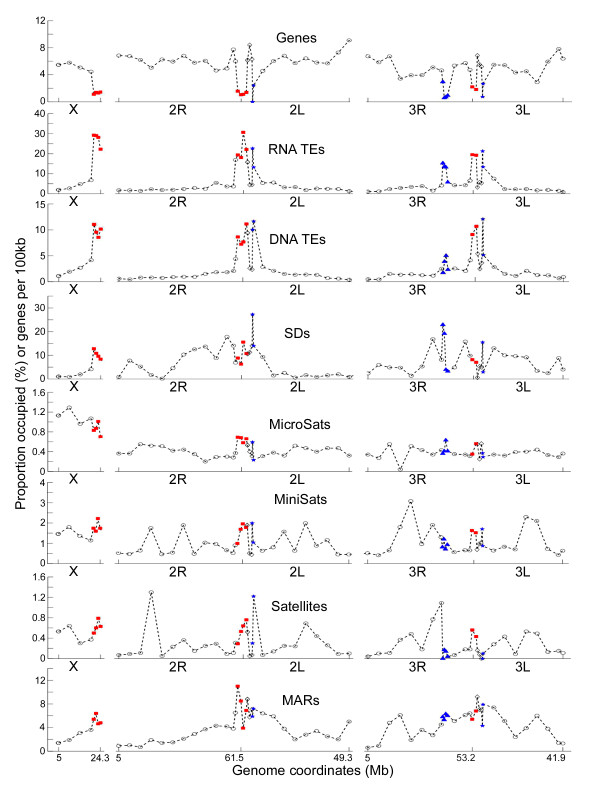
Genome landscapes of the An. gambiae heterochromatin and euchromatin. Median values of coverage of molecular features are displayed as 5-Mb intervals in euchromatin (open circles) and < 1-Mb intervals in heterochromatin. Red squares--pericentric heterochromatin, open diamonds--proximal euchromatin, blue stars--diffuse intercalary heterochromatin, blue triangles--compact intercalary heterochromatin.